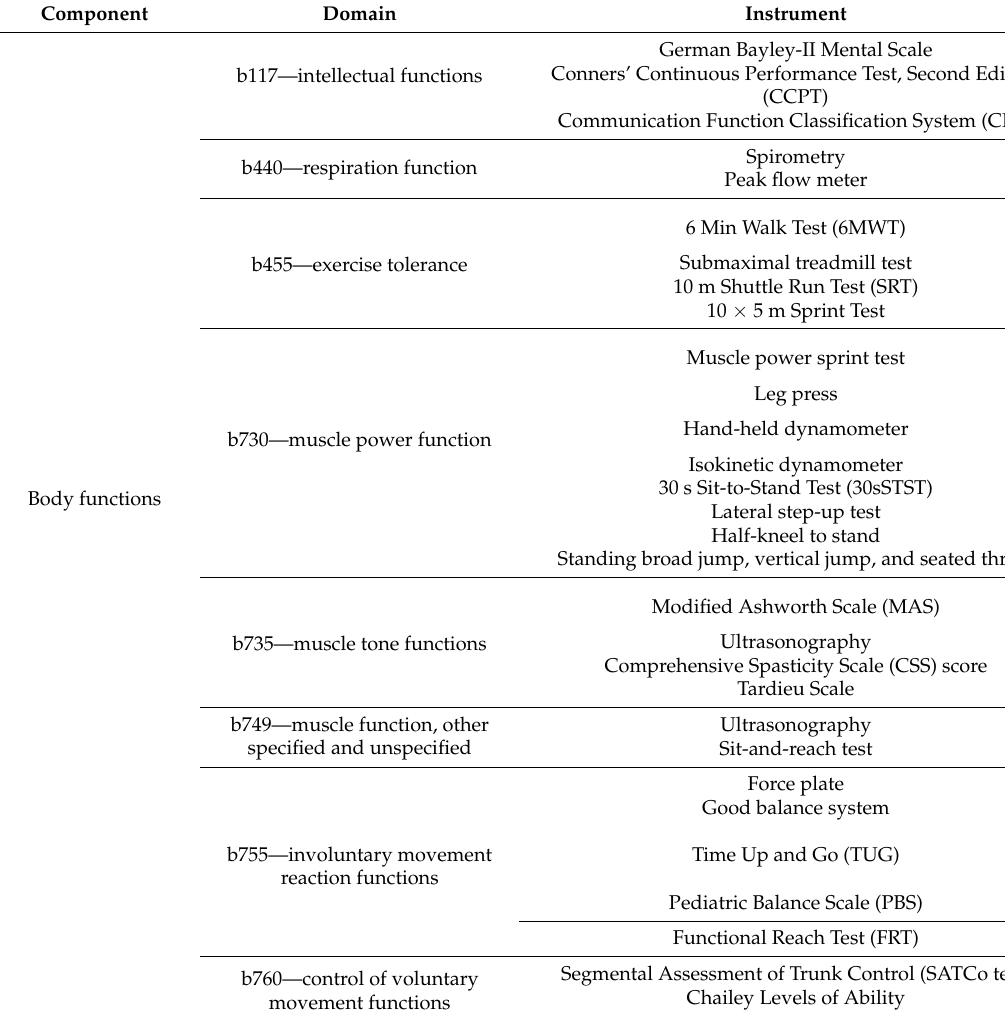
Table 1. Relationship between variables and instruments for assessment of individuals with CP based on International Classification of Functioning, Disability, and Health (CIF) domains.